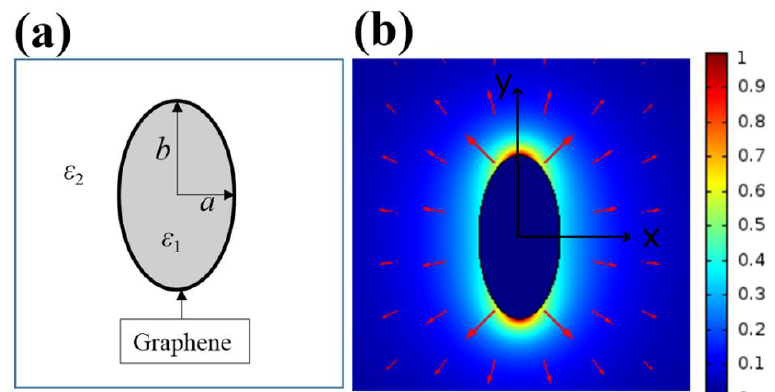
Figure 1. ( a ) The cross section of the graphene-coated elliptical nanowire (GCENW) waveguide. ( b ) Normalized electromagnetic energy distribution of the graphene plasmon (GP) mode at 3 THz. Red arrows indicate the polarization directions. The short axis and long axis are a = 0.5 μm and b = 1 μm, respectively. The other parameters are u c = 0.5 eV, ε 1 = 2.25, and ε 2 = 1.